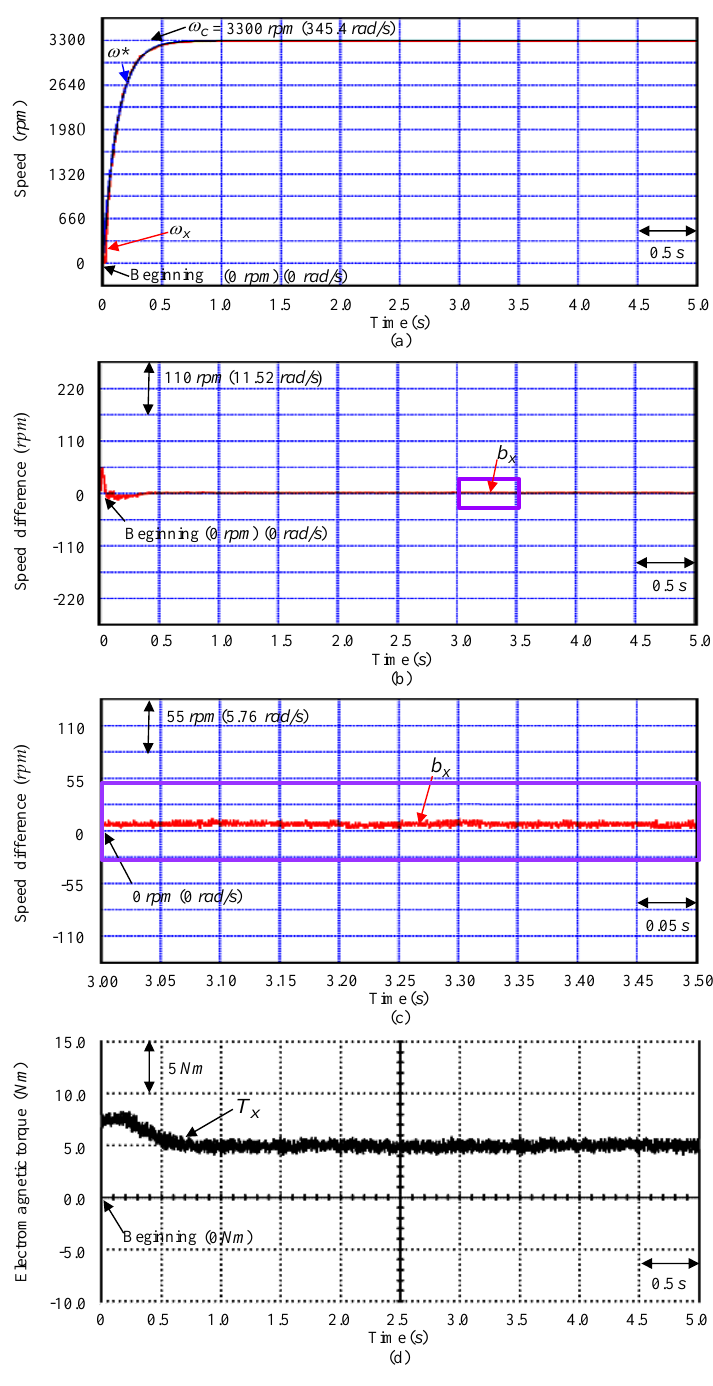
Figure 11. Tested instances with experimental results obtained by using the controller CD3 for the SSCCRIM impelled continuously variable transmission assembled system at the examination Y2 instance: ( a ) speed response, ( b ) speed response, ( c ) enlargement of speed difference response, ( d ) electromagnetic torque response .